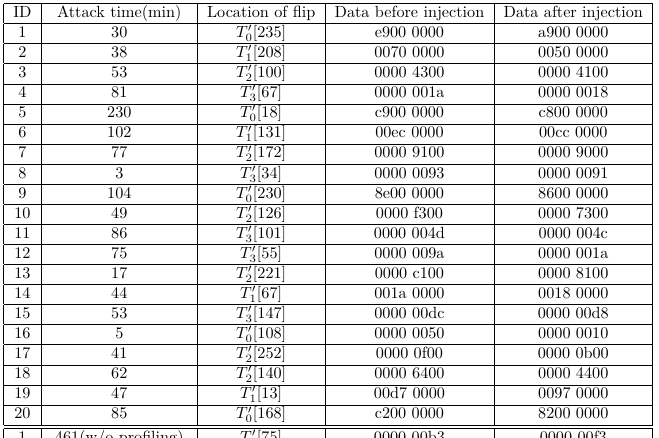
Table 3: The attack result for injecting one bit flip to any of T 0